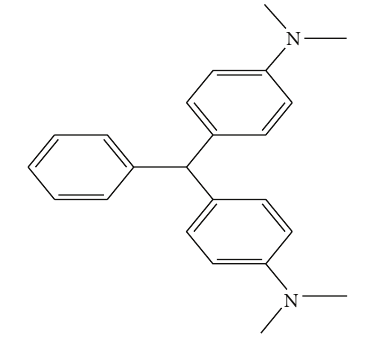
Figure 1: Chemical structure of malachite green